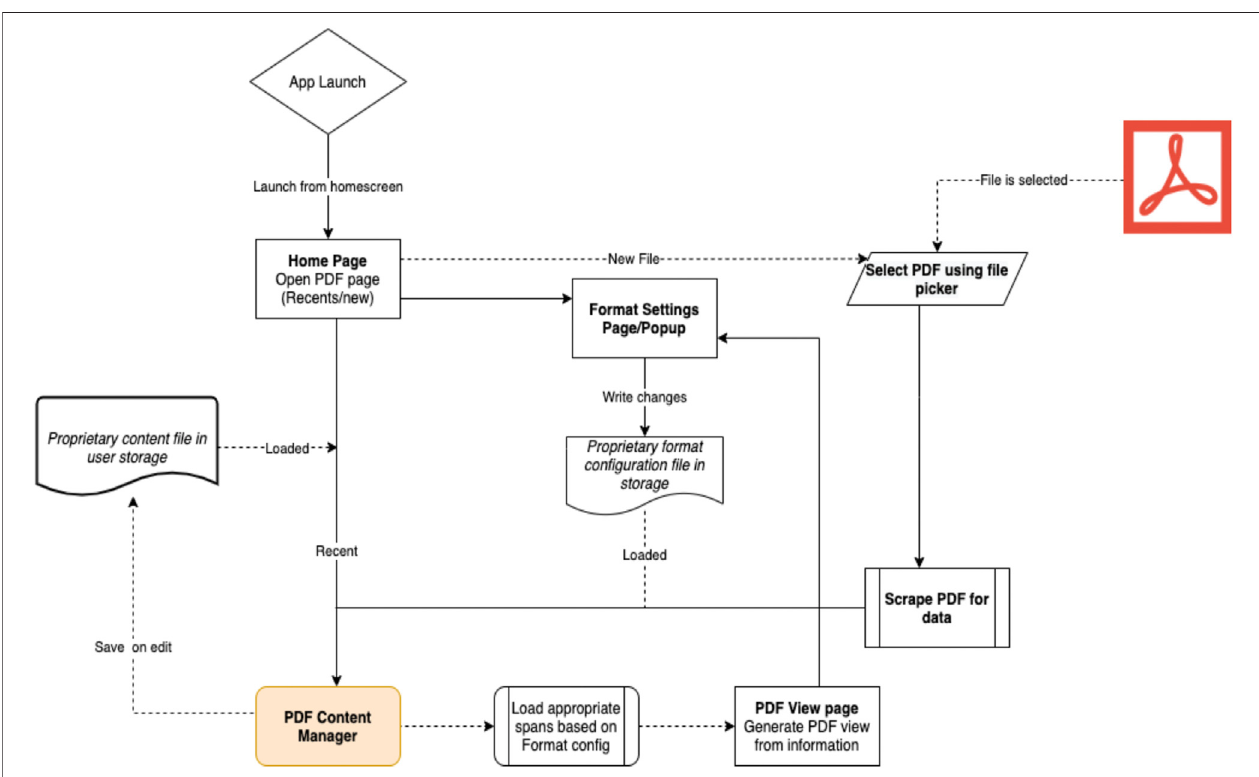
FIGURE 7 | PDFroggy++ — the usage